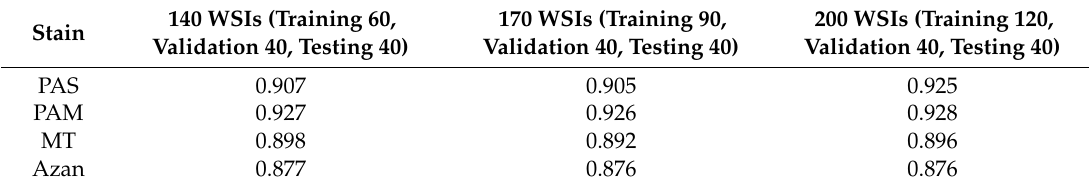
Table 4. Glomerular detection performance (F ‐ measure) according to the number of WSIs to be used. Stain